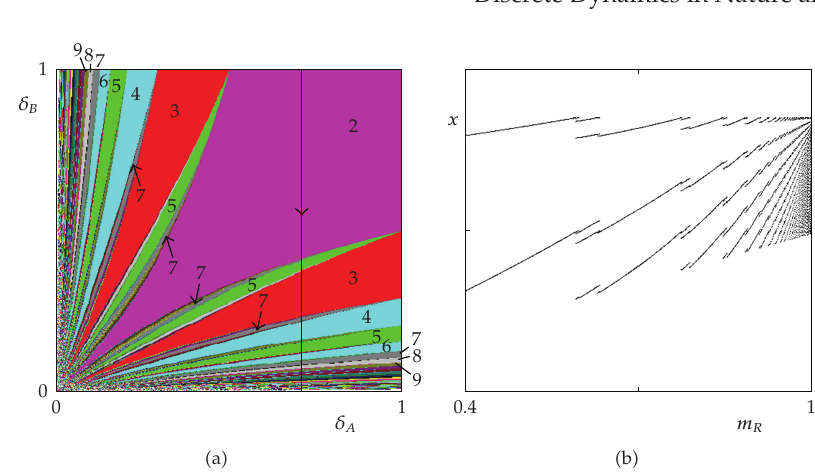
Figure 9: (cid:2) a (cid:3) Bifurcation diagrams in the parameters’ plane (cid:2) δ A ,δ B (cid:3) with d (cid:7) 0 . 5. The regions of periodicity are represented by di ff erent colors; (cid:2) b (cid:3) Bifurcation diagram obtained with a fixed value of δ A (cid:7) 0 . 7 and m R (cid:7) 1 − δ B anging from 0 . 4 up to